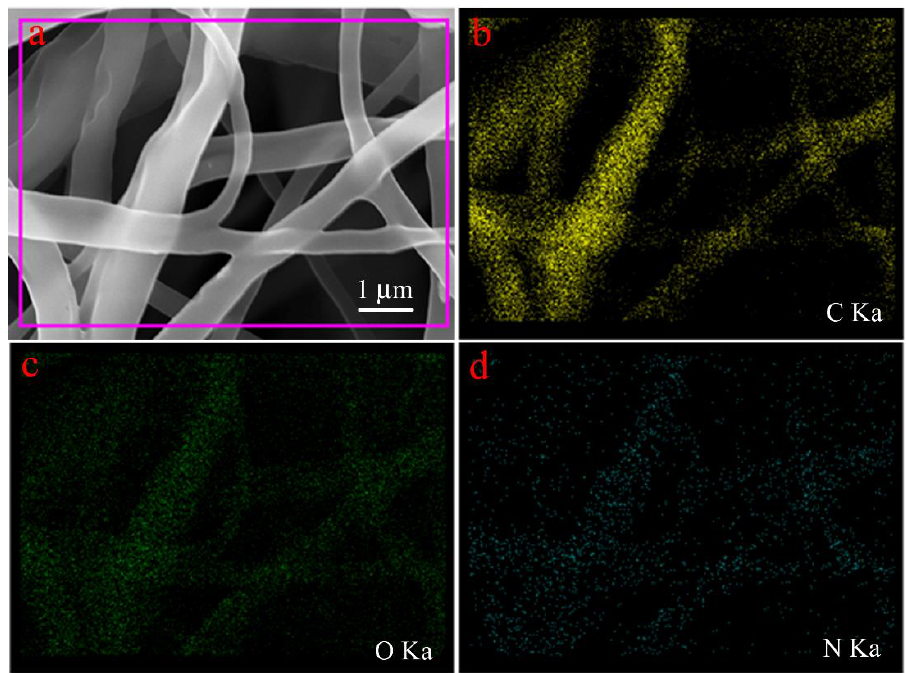
Figure 9. SEM image ( a ) with C/O/N elemental mapping ( b , c , d ) of AA-absorbed PCL/(50%)PCD composite fibers.